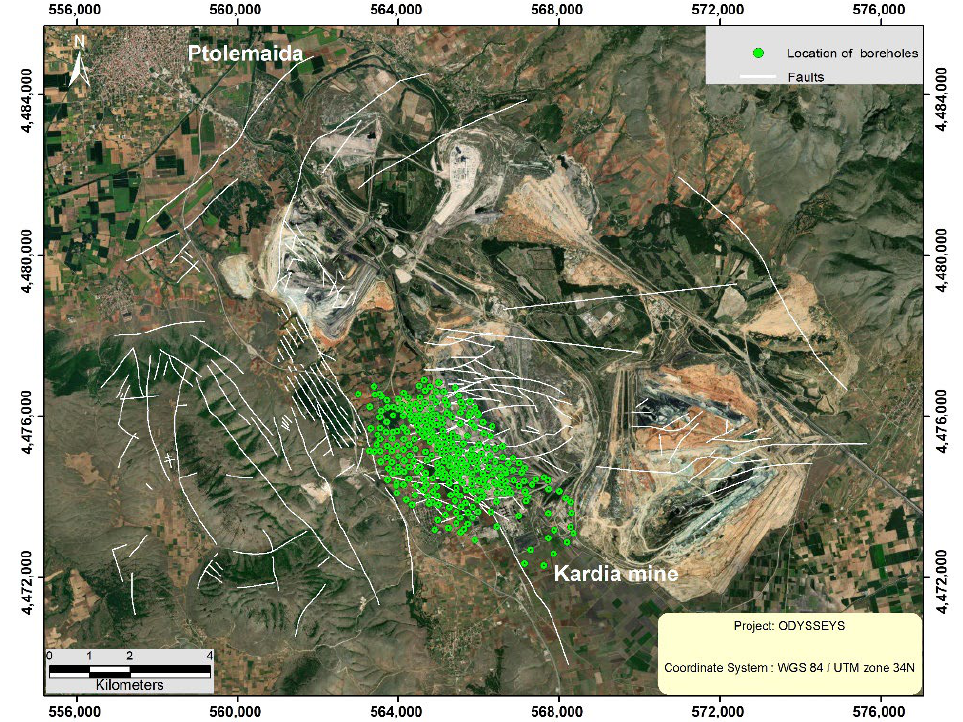
Figure 6. The map represents the spatial location of the digitized faults in the broader area of the Kardia lignite mine. The base map is provided by Sentinel 2b satellite European Union—Copernicus program) with sensing date: 31 August 2021.